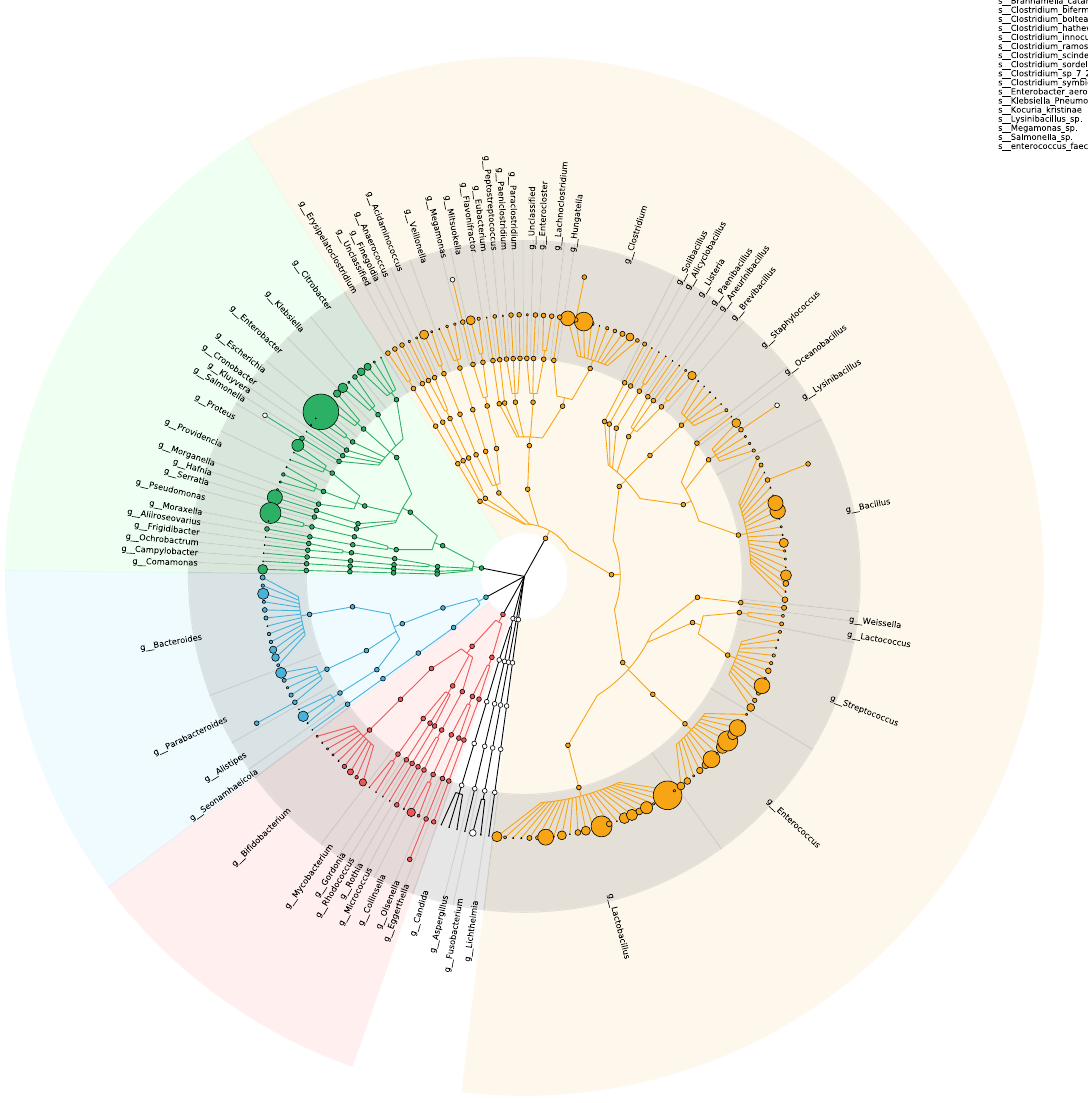
Fig. 7 Phylogenetic tree based on the gut bacteria obtained by culturomics. Orange, black, red, blue, and green branches represent Firmicutes, Fusobacteriota, Actinobacteria, Bacteroides, and Proteobacteria, respectively. The area of the circles stands for the number of isolated strains belonging to each